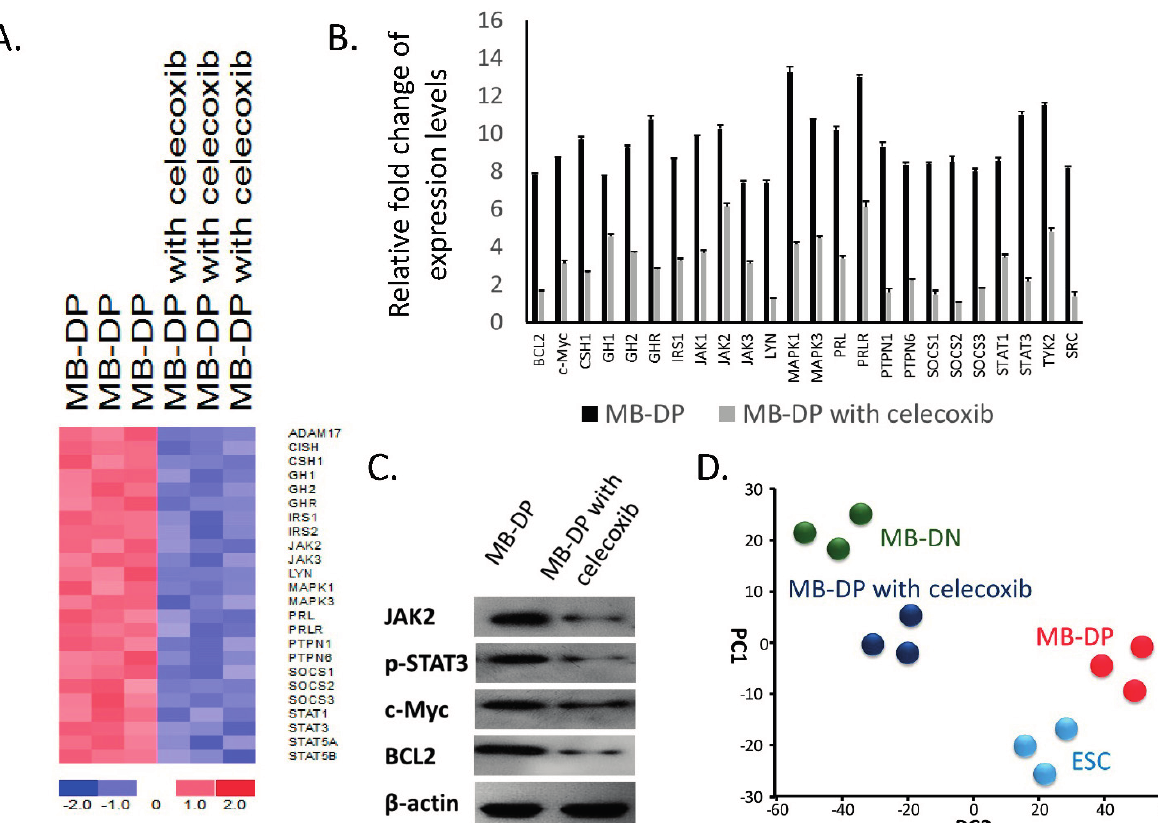
Figure 4. Celecoxib treatment shifted the gene signature profiles of MB-DPs